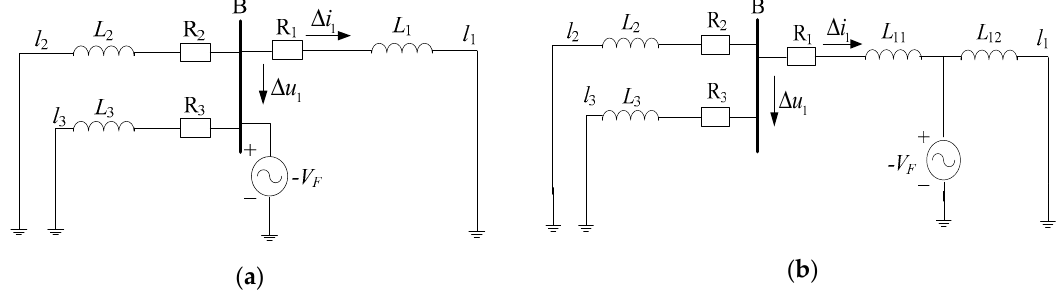
Figure 2. The ( a ) fault superimposed network when a fault at f 1 on busbar B occurs. The ( b ) fault superimposed network when a fault at f 2 on l 1 occurs.